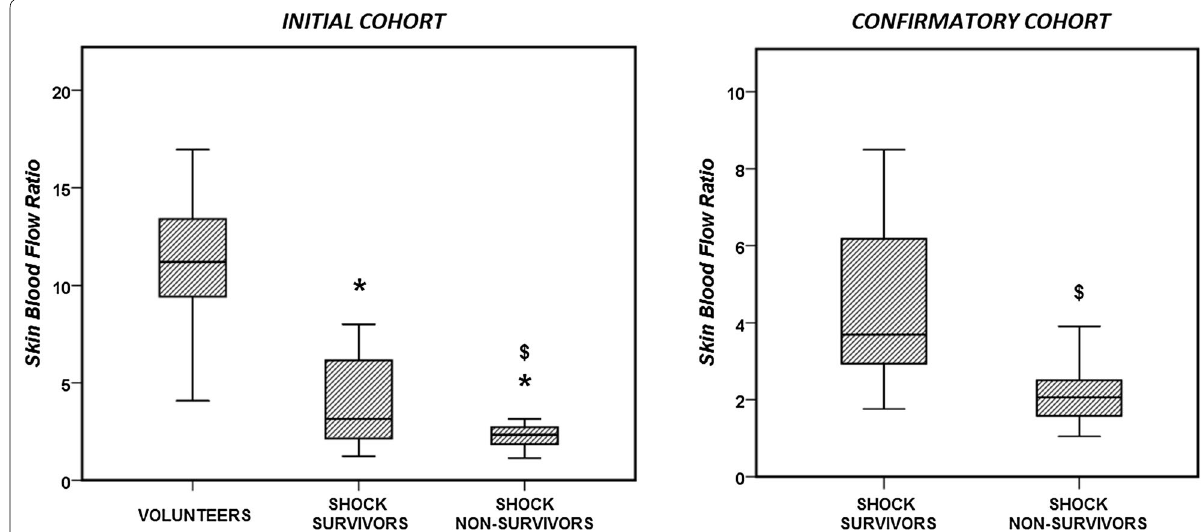
Fig. 2 Comparison of the capillary reactivity, evaluated as the skin blood flow ratio, in the healthy volunteers and the patients with circulatory shock (initial and confirmatory cohorts). * p < 0.05 compared with healthy volunteers; $ p < 0.05 compared with survivors